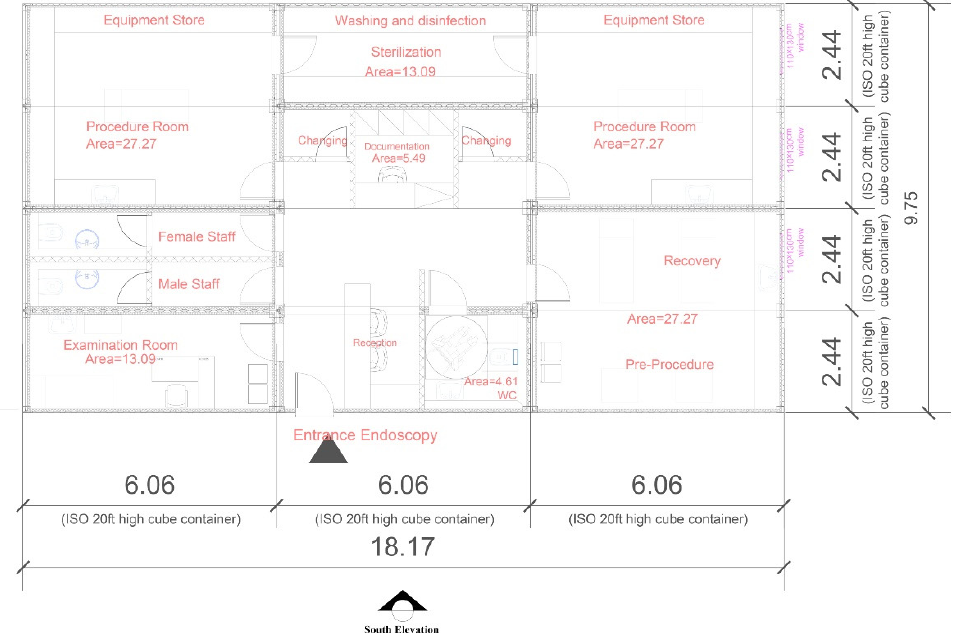
Figure A7. Endoscopy department plan of the relocatable hospital in Mosul.